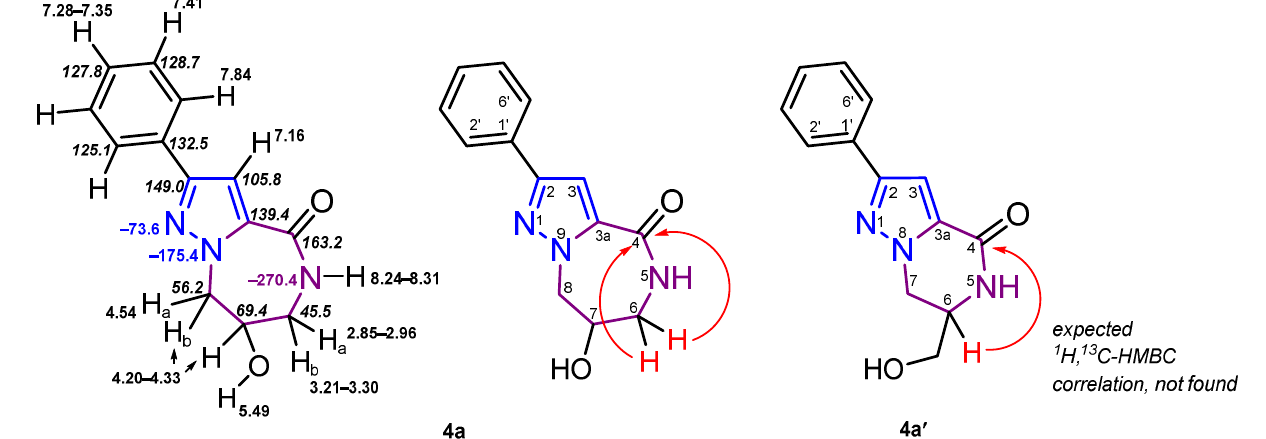
Figure 3. Determination of possible isomeric structures 4a and 4a′ . Relevant 1 H, 13 C-HMBC correla- tions and 1 H NMR, 13 C NMR (italic), 15 N NMR (in blue) chemical shifts of compound 4a .